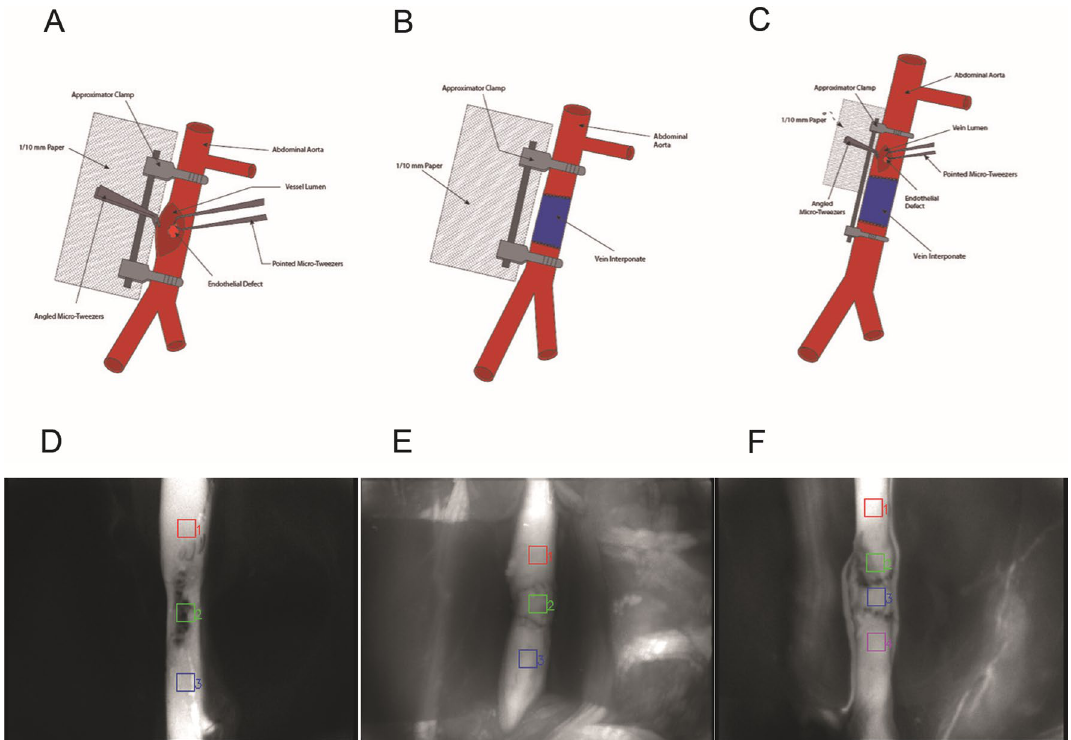
Figure 1. Three experimental groups. ( A ) and ( D ) endothelial defect (ED, group I); ( B ) and ( E ) interposition vein graft (IVG, group II); and ( C ) and ( F ) ED with IVG (group III) with corresponding regions of interest (ROI,